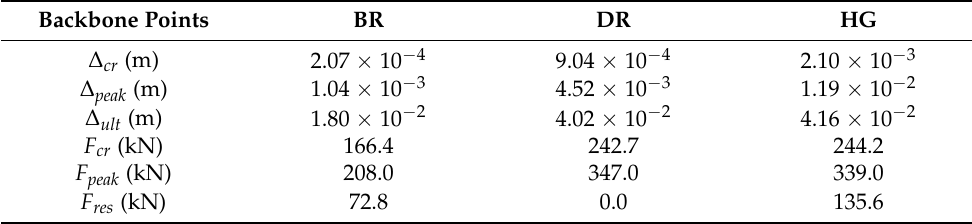
Figure 6. Lateral force-displacement equivalent strut backbone curves for a solid infill panel adopting DR, HG, and BR. Table 2. Backbone curve points for the reference infill